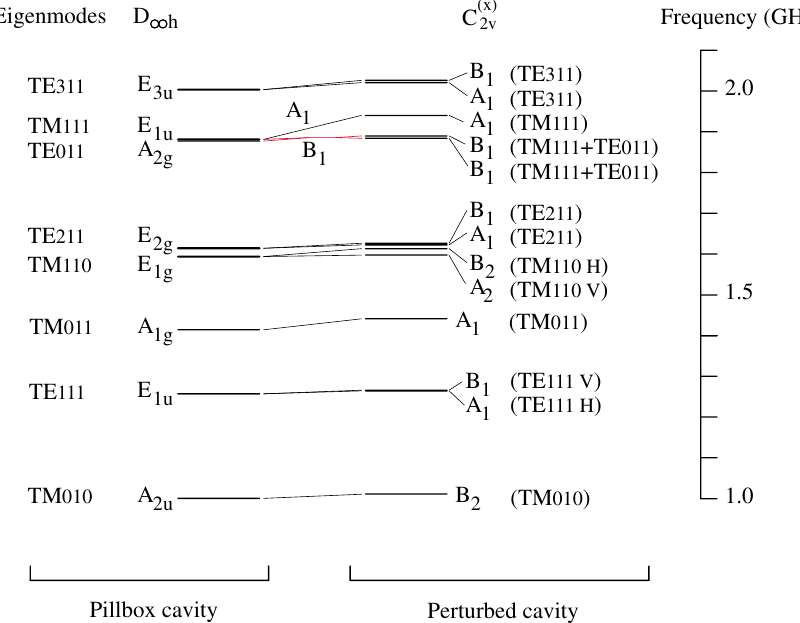
FIG. 6. (Color) Calculated mode spectra for the cavity in Fig. 5, together with those for the original pillbox cavity. The thick lines for the pillbox cavity indicate twofold degeneracy.